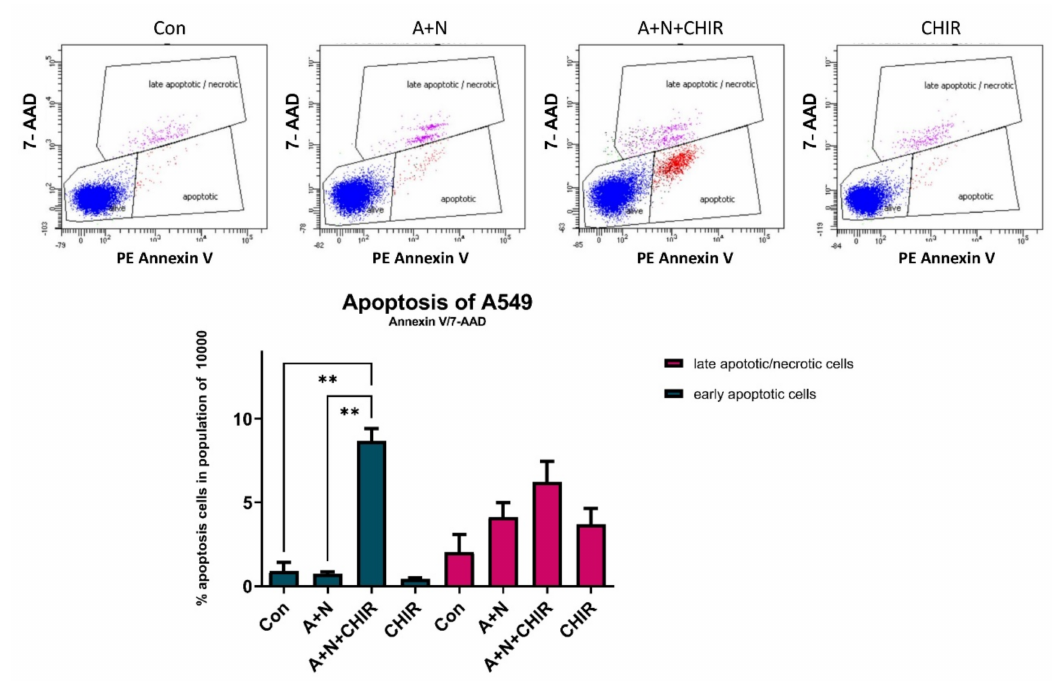
Figure 6. Flow cytometry analysis confirms ability of CHIR-98014 to induce apoptosis in cells exposed to A + N. Cytometric analysis of cell populations mock-treated (Con) or exposed to A + N, A + N with CHIR-98014 or CHIR-98014 alone for 48 h. Viable cells are 7-AAD (7-Amino-Actinomycin) negative and PE Annexin V negative; cells in early apoptosis are PE Annexin V positive and 7-AAD negative, whereas late apoptotic or dead cells are both PE Annexin V and 7-AAD positive. The graph below shows the frequency of indicated cell types calculated from three biological repeats ( p values calculated by Brown-Forsythe and Welch’s ANOVA tests (** p <